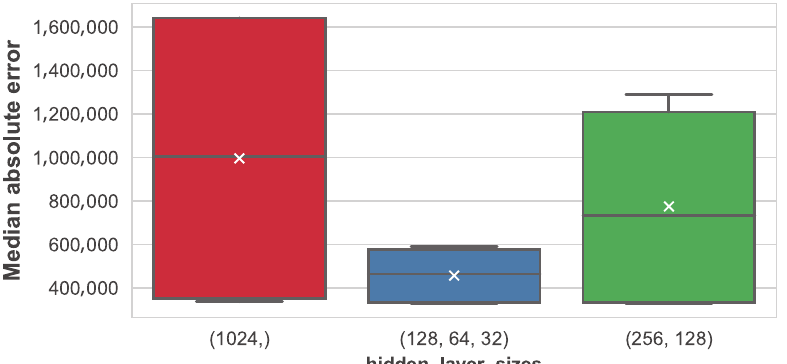
Figure 11. Distribution of the median average error based on the different parameters for the k -nearest neighbors.